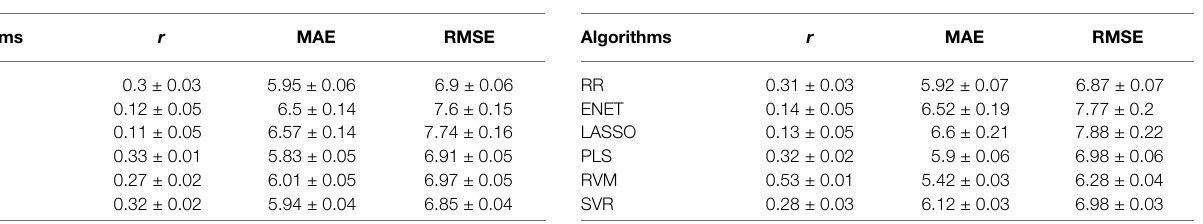
TABLE 2 | Performance of predictive models based on mRMR with GSR and